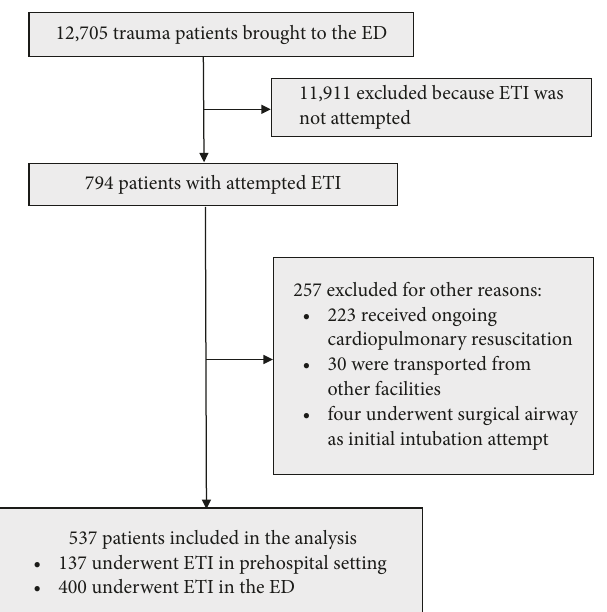
Figure 1: Flow chart showing the selection process for injured patients who underwent ETI in prehospital or emergency department setting. ED emergency department, ETI endotracheal